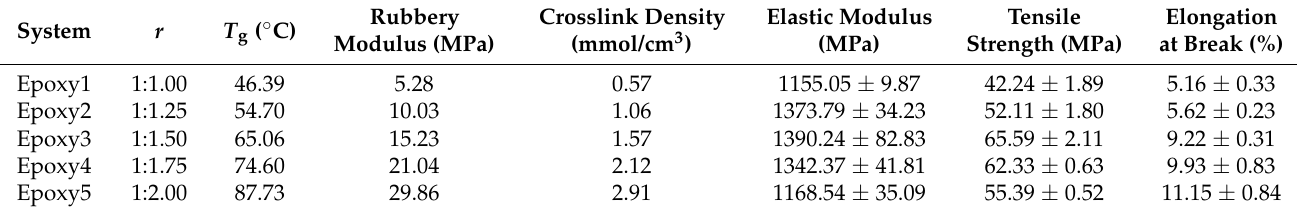
Figure 5c plotted the stress-strain curves of five epoxy resins, and the changes in